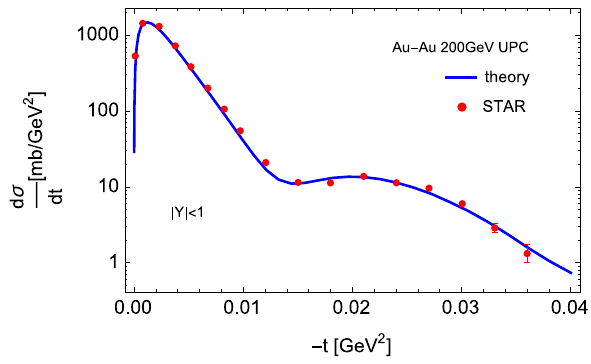
Figure 3 . (color online) The unpolarized cross section for coherent (cid:26) 0 photo-production in XnXn events at RHIC energy. The red dots are experimental data points taken from [25]. The blue line shows our numerical result for this unpolarized cross section.